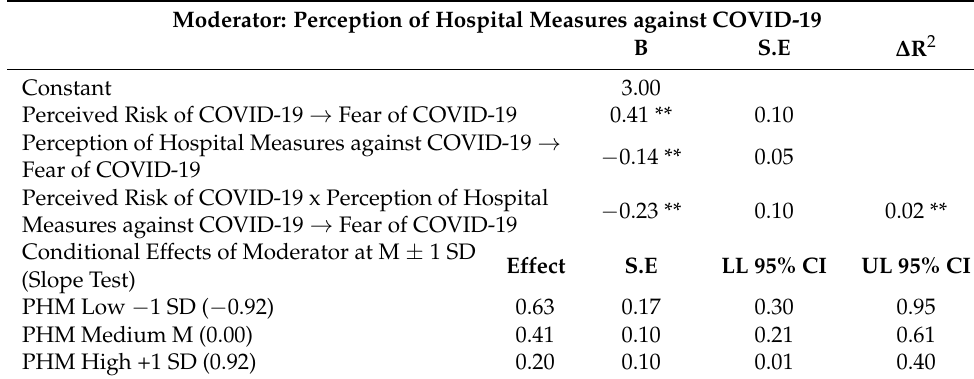
Table 6. Moderation analysis.